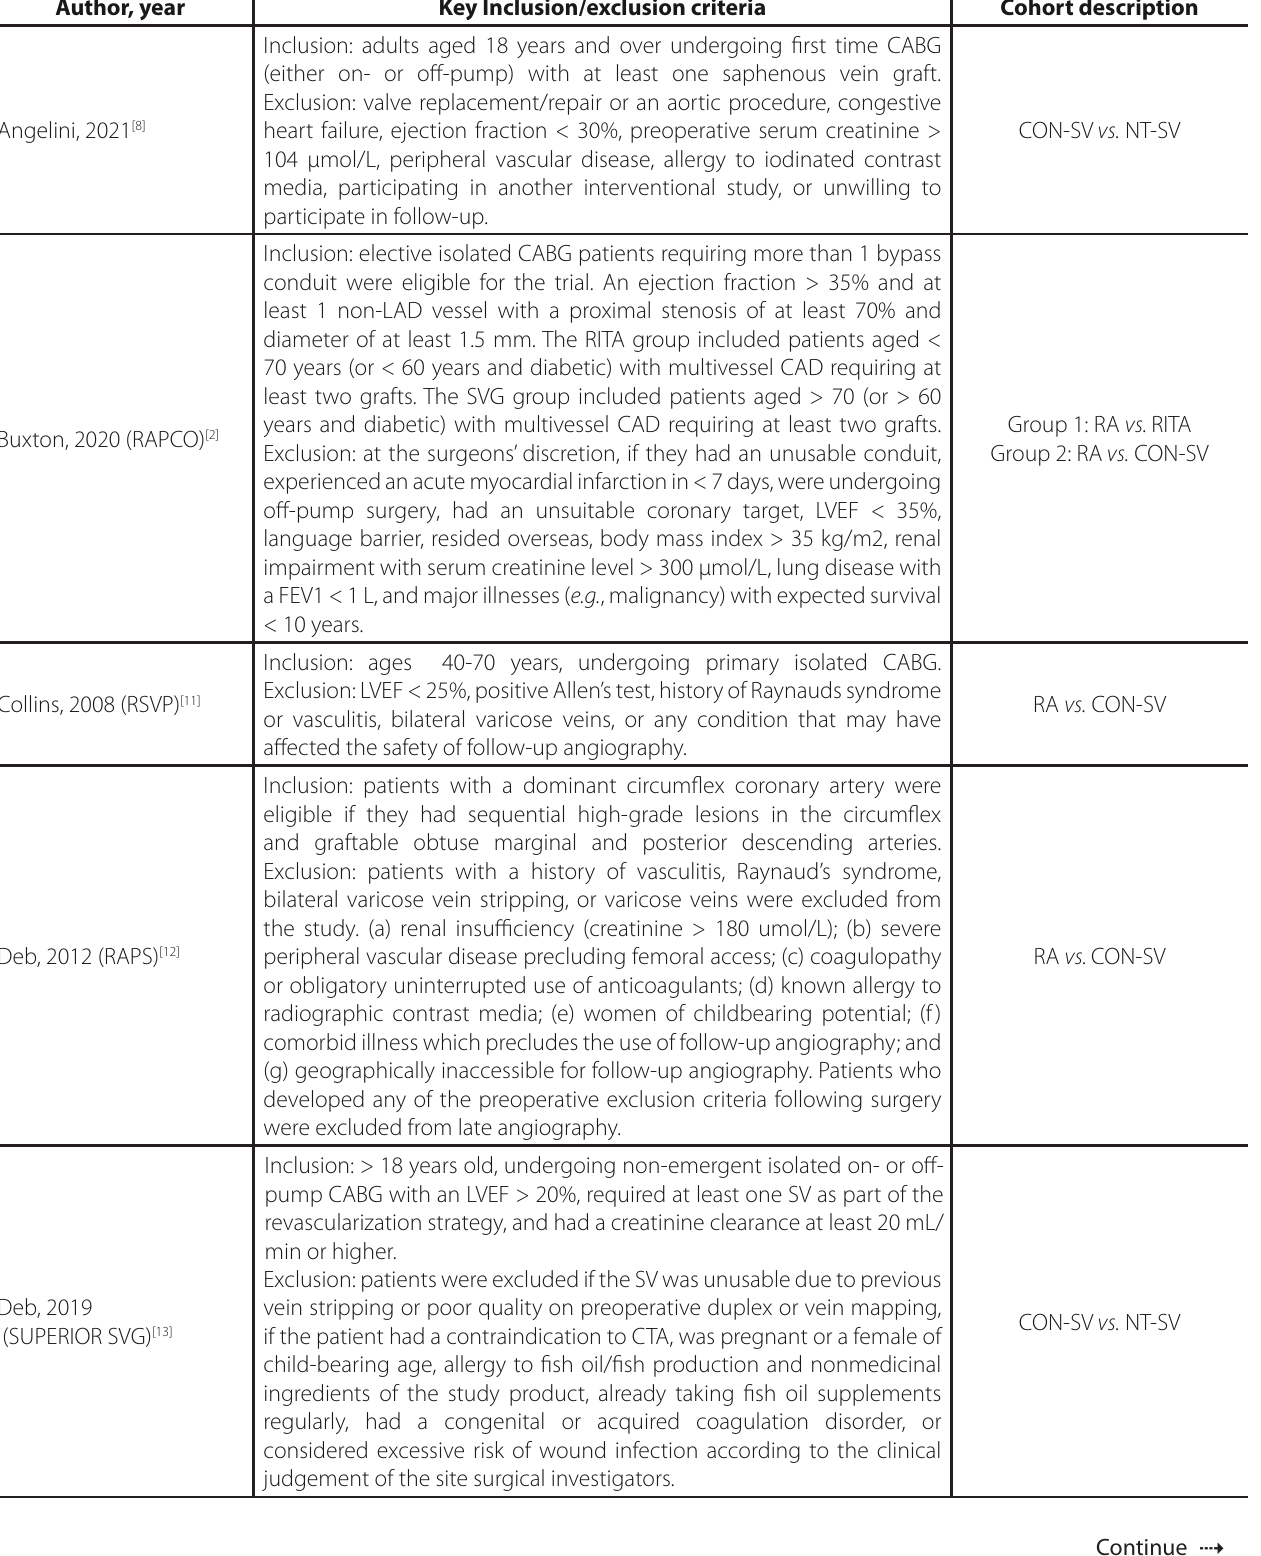
Table S2. Inclusion and exclusion criteria of the included trials. Key Inclusion/exclusion criteria Cohort